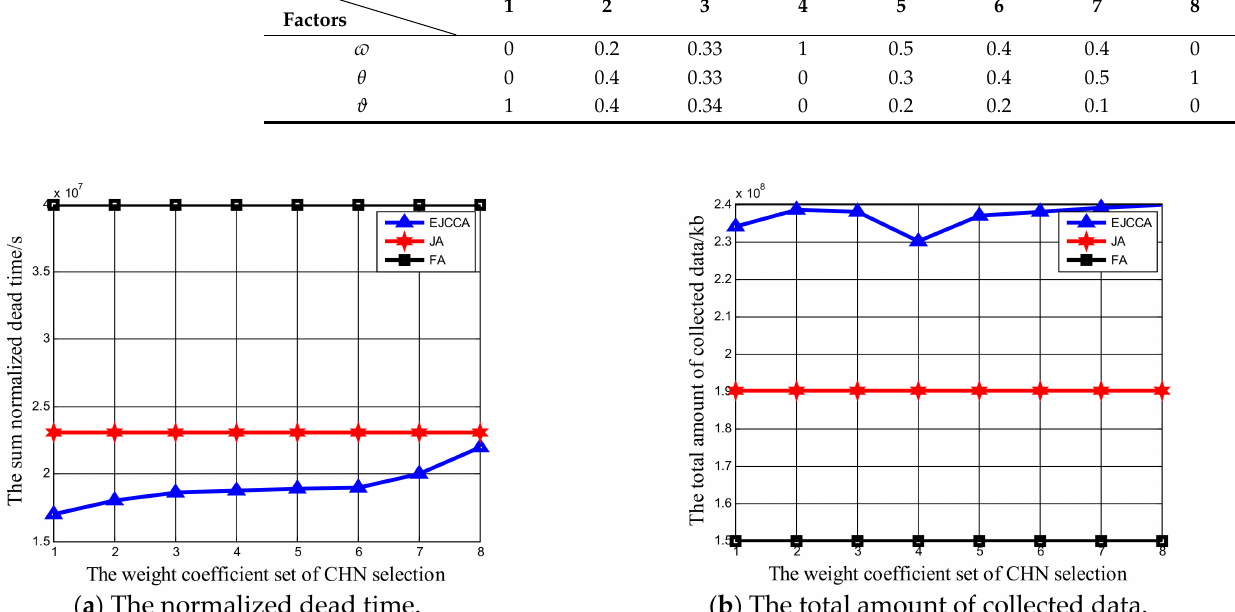
Figure 7. The influence of weight coefficient set of CHN selection on the network performance.